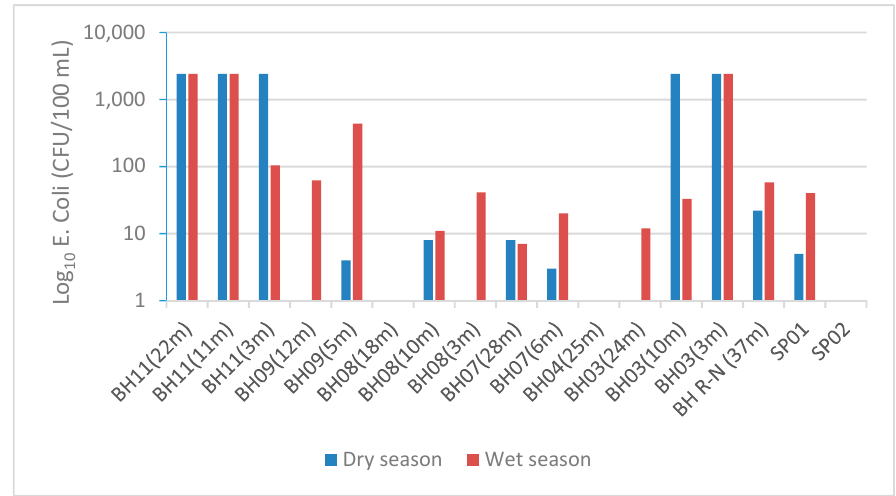
Figure 3. Prevalence of E. coli contamination in the sampled sources in the study area.